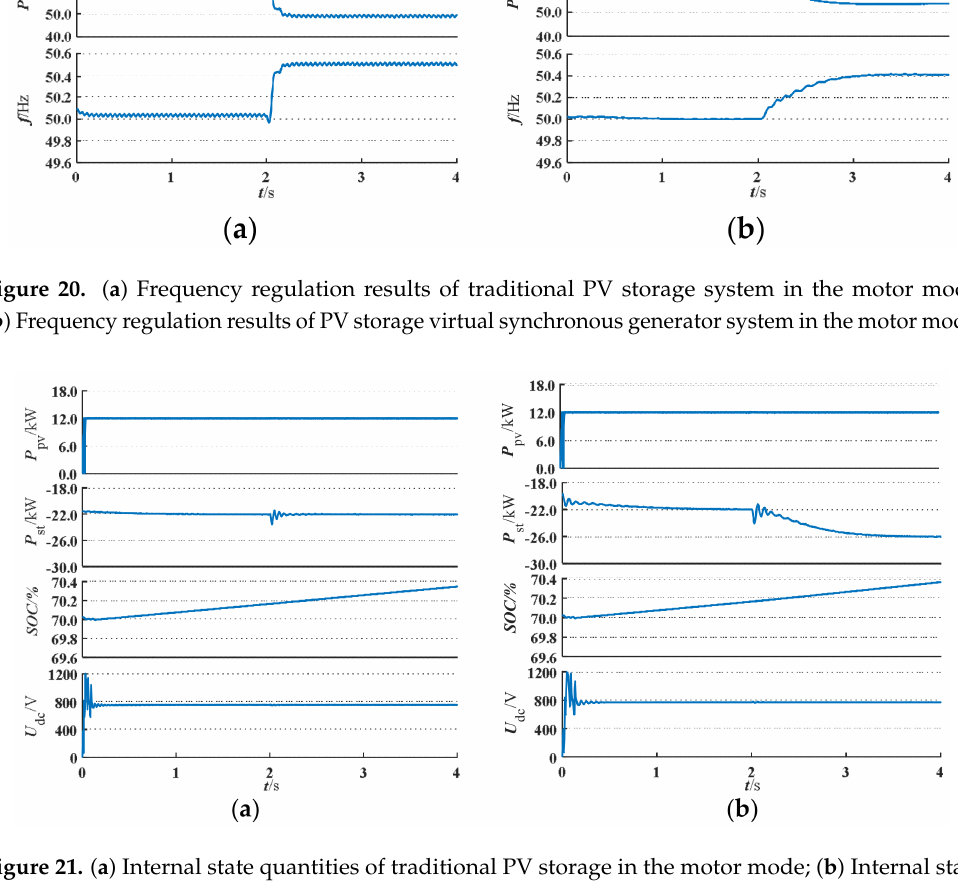
Figure 21. ( a ) Internal state quantities of traditional PV storage in the motor mode; ( b ) Internal state quantities of PV storage virtual synchronous generator system in the motor